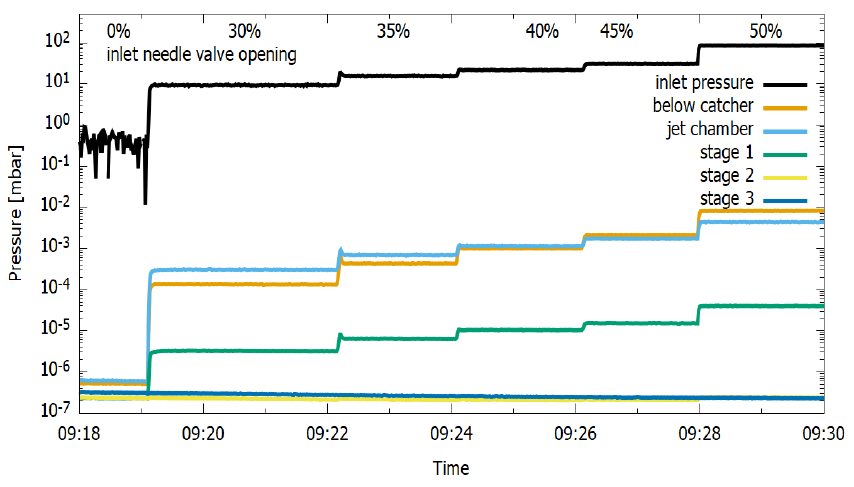
Figure 6. Pressure profile measurements inside the chamber and beam line at di ff erent needle valve opening connected to the